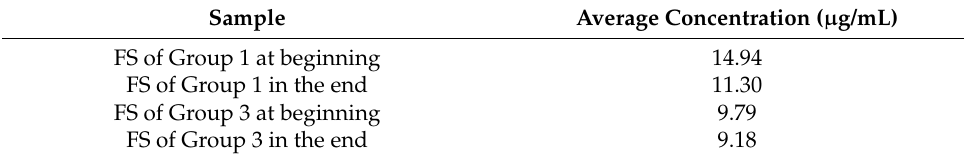
Table 4. The concentration of protein in FS in the FO system.